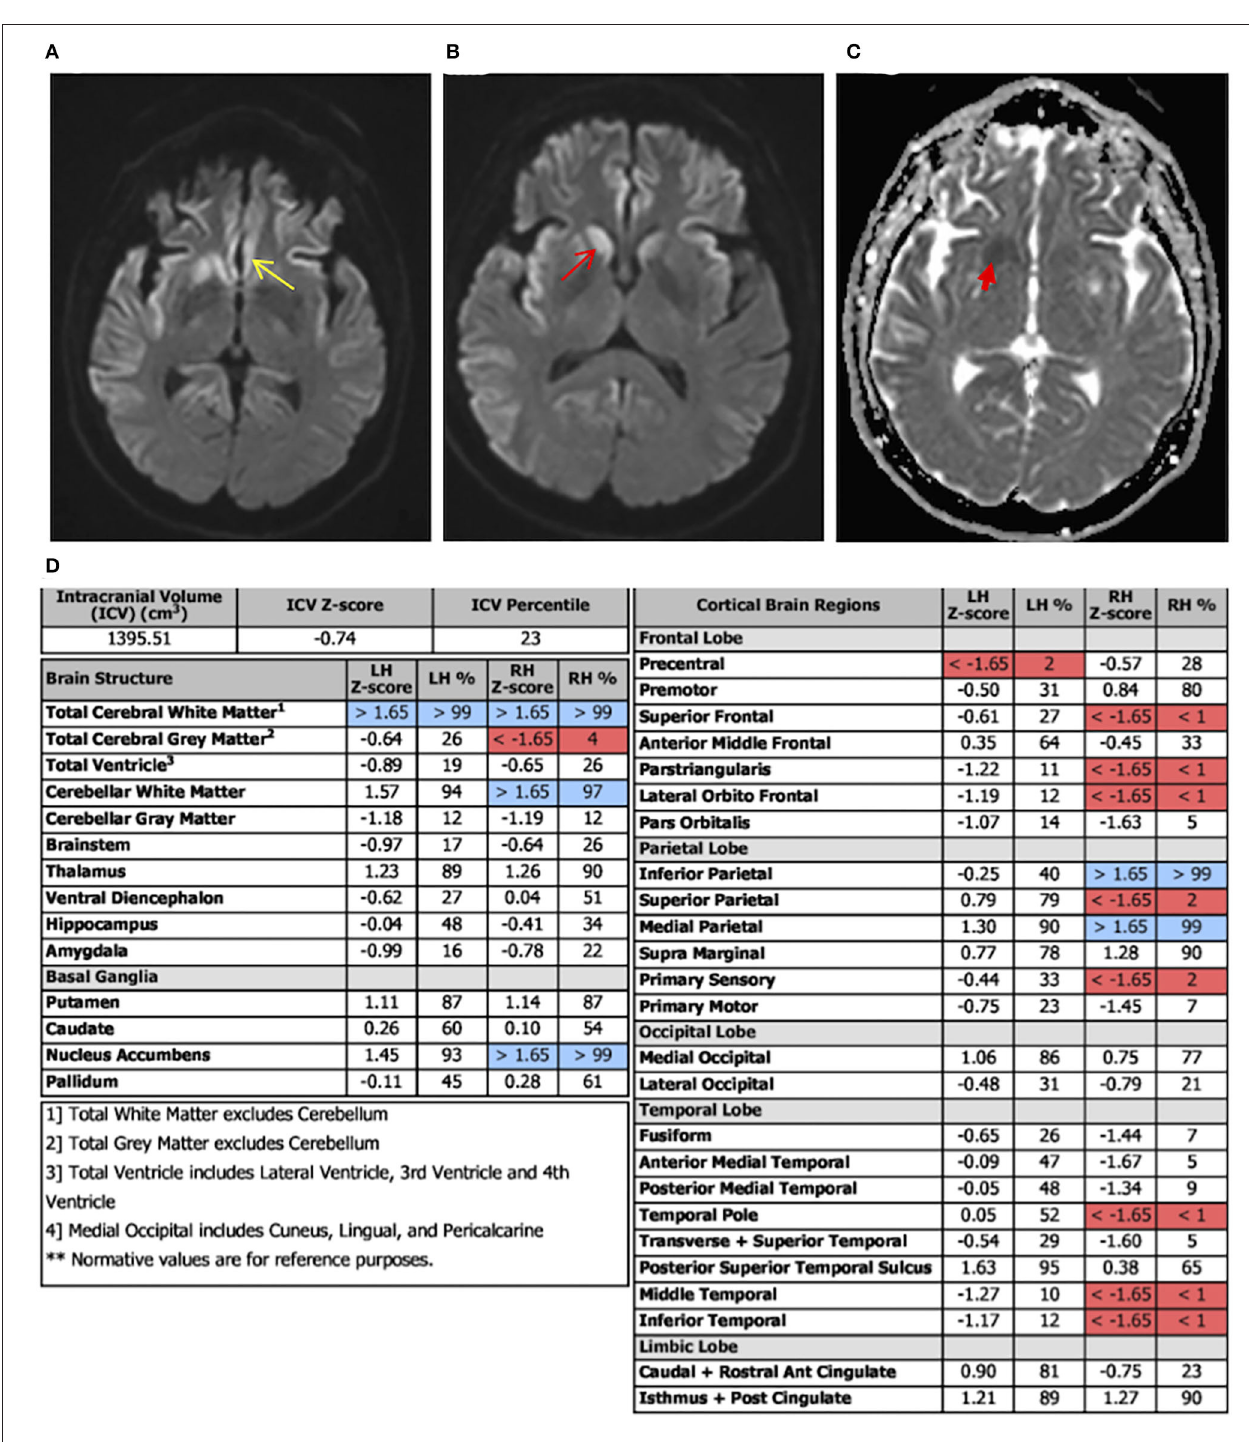
FIGURE 1 | Case report